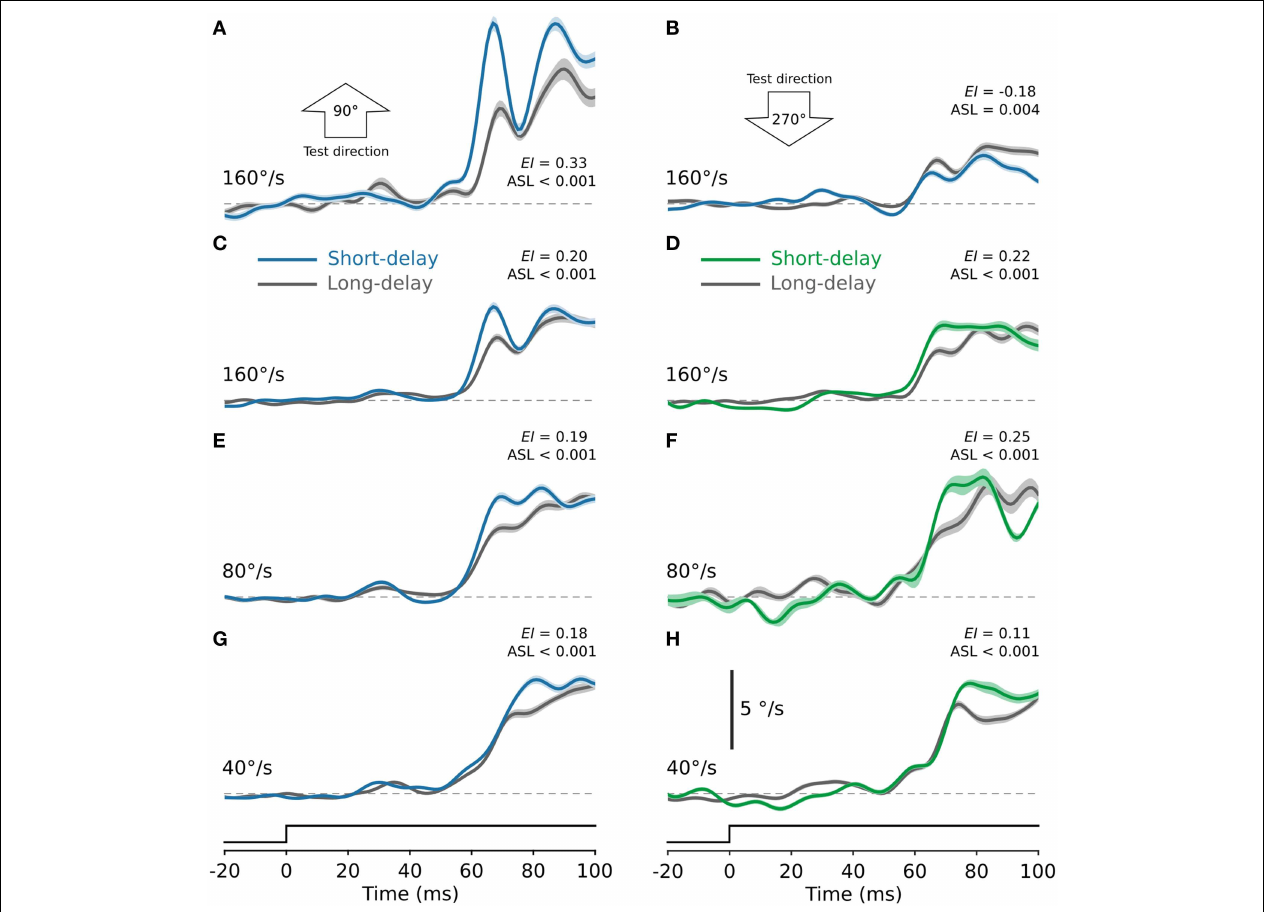
FIGURE 4 | Enhancement of ocular following eye speed after real and simulated saccades and the effect of test direction. (A,B) Ocular following eye speed from one monkey for test stimuli presented after real saccades. In (A) the test stimuli were moving upward at 160 ◦ /s. Ocular following was robust for this test direction, and eye speed was significantly enhanced in the short-delay condition (blue) compared to the long-delay condition (gray). In (B) the test stimuli were moving downward at 160 ◦ /s. For this test direction ocular following was poor, with no evidence of post-saccadic enhancement. Ocular following was consistently poor for test stimuli moving in the downward direction. The remaining panels, (C–H) , show ocular following eye speed for test stimuli moving at 160, 80, and 40 ◦ /s, averaged across all directions tested. Panels on the left [ (C) , 160 ◦ /s; (E) , 80 ◦ /s; (G) , 40 ◦ /s] show eye speed for test stimuli presented after real saccades. In all cases, ocular following eye speed was significantly enhanced in the short-delay condition (blue) compared to the long-delay condition (gray; ASL < 0.001). Panels on the right [ (D) , 160 ◦ /s; (F) , 80 ◦ /s; (H) , 40 ◦ /s] show corresponding ocular following eye speed for test stimuli presented after simulated saccades. Again, in each case ocular following eye speed was significantly enhanced in the short-delay condition (green) compared to the long-delay condition (gray; ASL < 0.001). In all panels, solid lines show eye speed signals averaged across all trials of a given speed and the shaded regions indicate ± 1 SE, estimated by